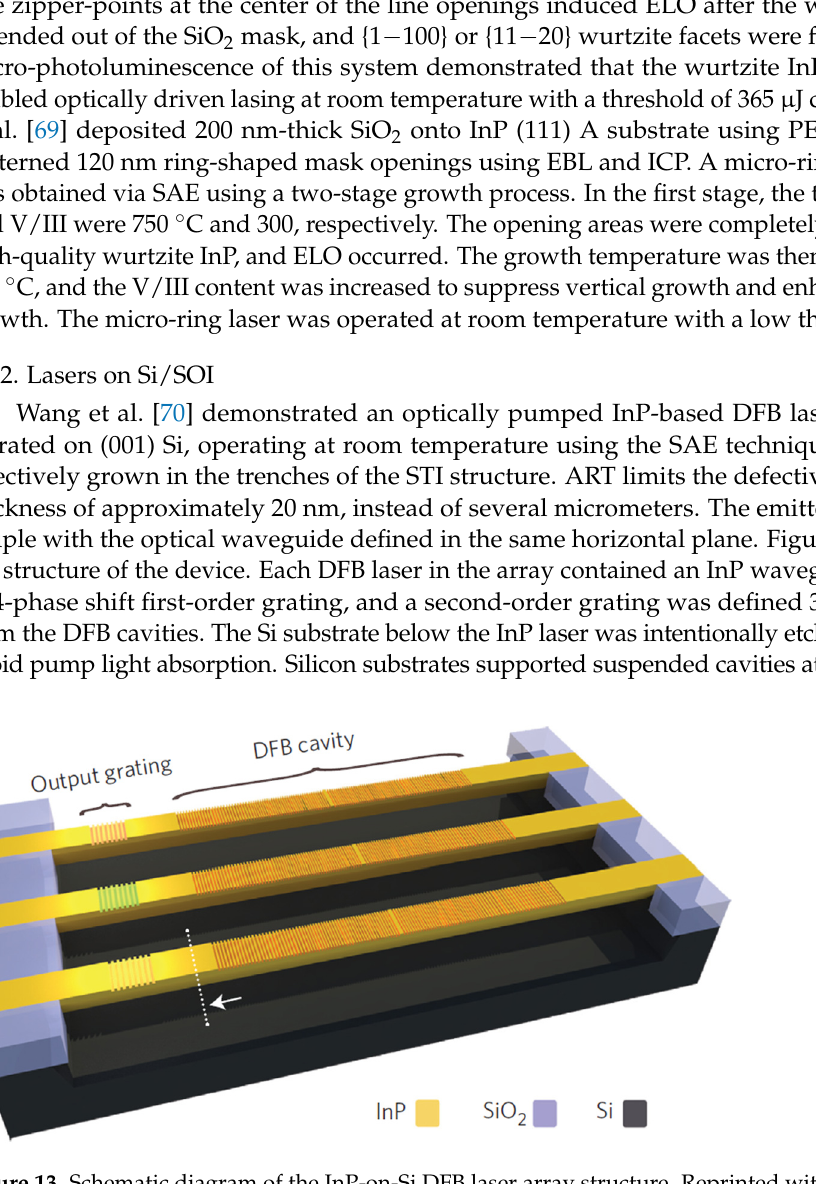
Figure 13. Schematic diagram of the InP-on-Si DFB laser array structure. Reprinted with permission from ref. [70] © Springer Nature. Copyright 2015 Nature Photonics.